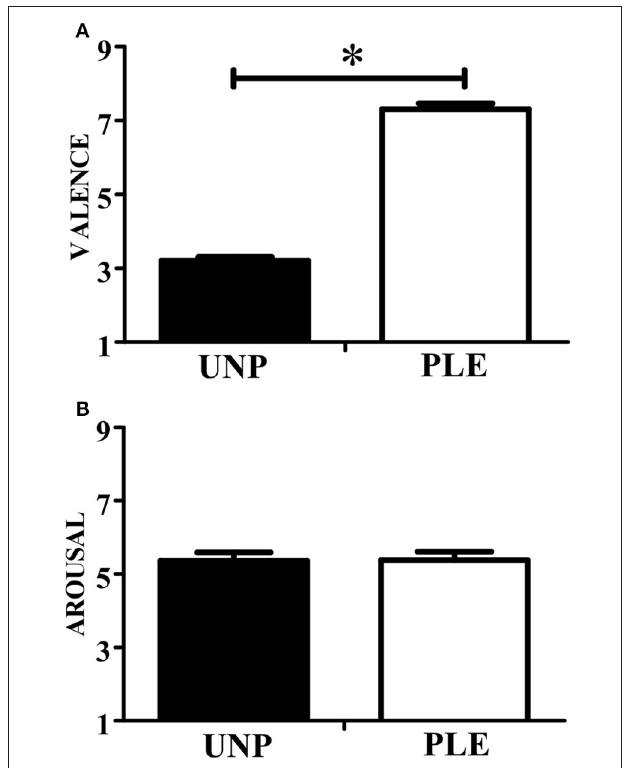
FIGURE 3 | Video-clip rating. (A) Scores for the valence dimension. (B) Scores for the arousal dimension. UNP, unpleasant and PLE, pleasant (* p < 0.05).